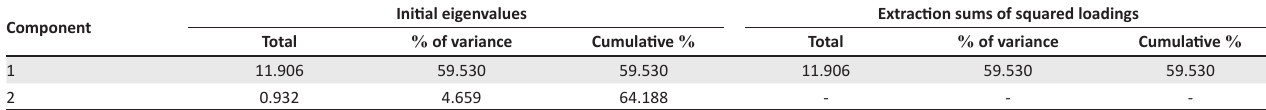
TABLE 2-A1: Total variance explained.